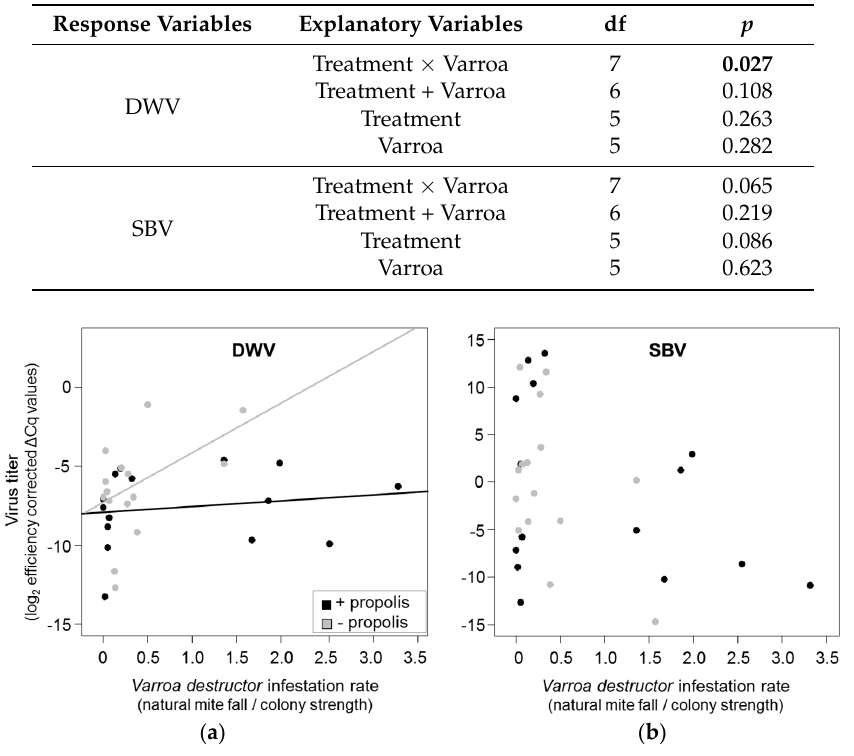
Table 2. Results of different mixed-effects models testing for effects of high and low propolis treatment (“Treatment”) and V. destructor infestation (“Varroa”) with (Treatment × Varroa) and without (Treatment + Varroa) interactions included (=explanatory variables) on titers of the deformed wing virus (DWV) and the sacbrood virus (SBV) (=response variables) over three months (number of samples N = 30, three repeats per colony). In all models, colony and month were included as random factors to take into account colony-specific differences and repeatedly measuring the same colony. Table shows degrees of freedom (df) and p-values ( p ) for comparing all models presented against the null model (i.e., a model including only colony and sampling date as random factors). Significant p -value is marked in bold.